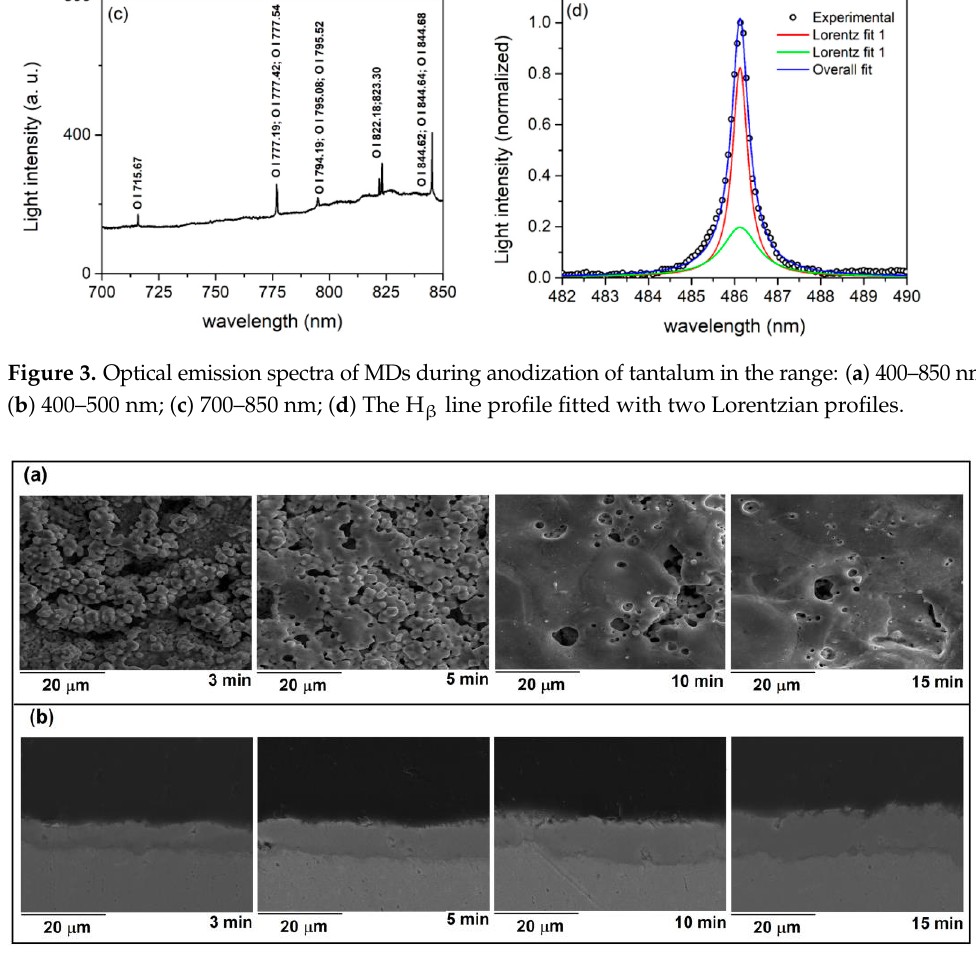
Figure 3. Optical emission spectra of MDs during anodization of tantalum in the range: ( a ) 400–850 nm; ( b ) 400–500 nm; ( c ) 700–850 nm; ( d ) The H β line profile fitted with two Lorentzian profiles.